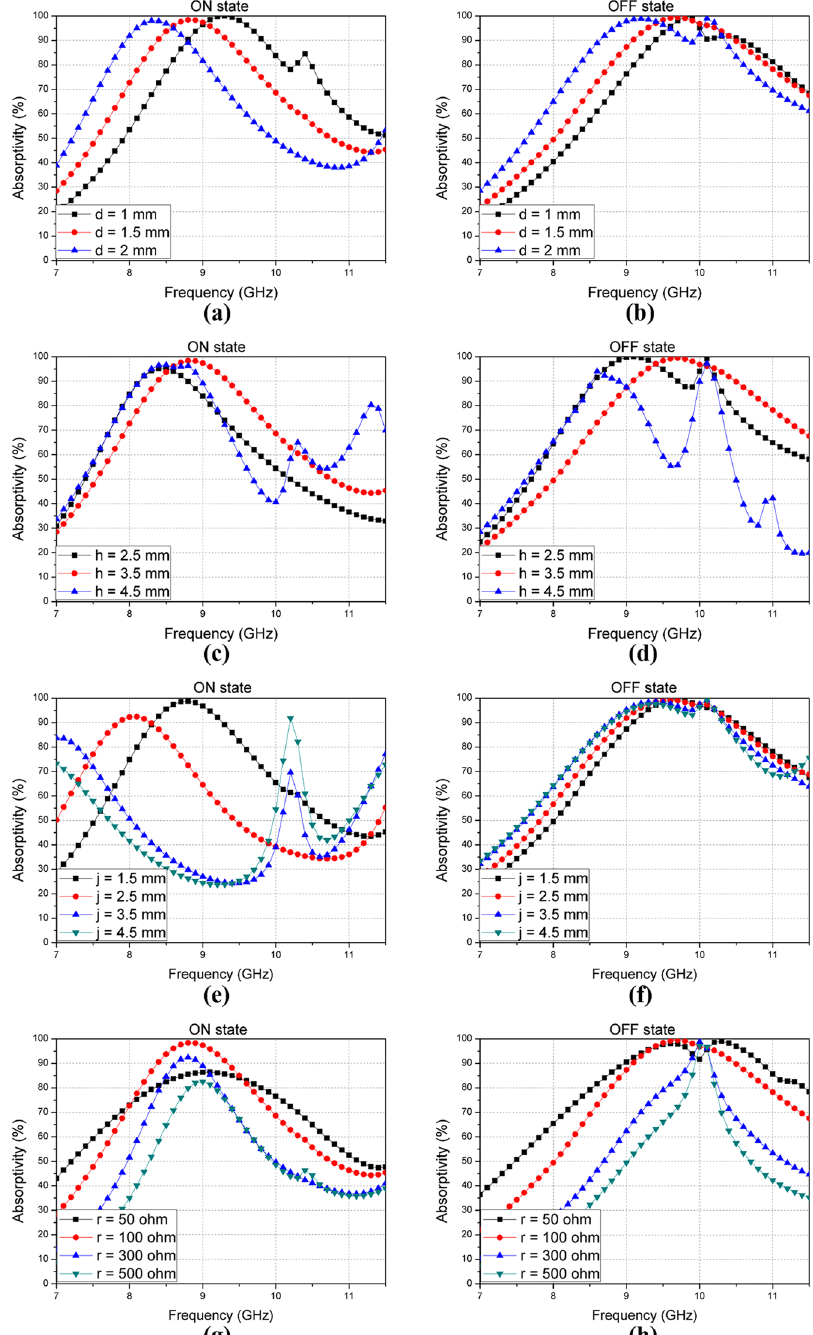
Figure 4. Simulated absorptivity at different values of design parameters: (a) ON state when value of ‘d’ varies from 1 mm–2 mm, (b) OFF state; (c) ON state when value of ‘h’ varies from 2.5 mm–4.5 mm, (d) OFF state; (e) ON state when value of ‘j’ varies from 1.5 mm–4.5 mm, (f) OFF state; (g) ON state when value of ‘r’ varies from 50 Ω–500 Ω, (h) OFF